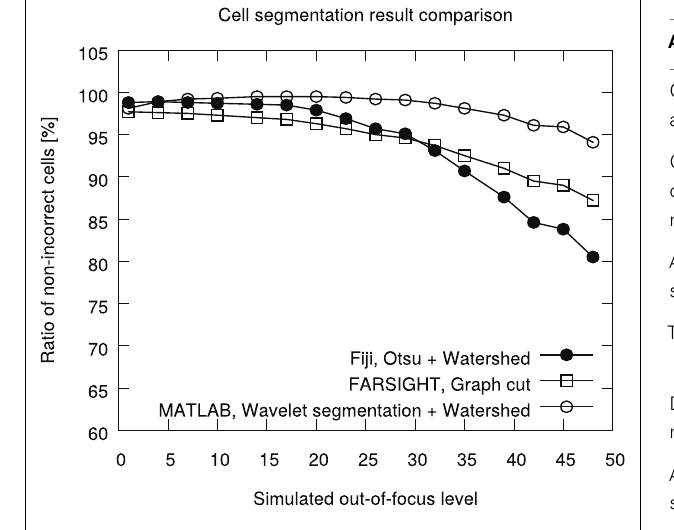
Table 3 |Applications built withAnima